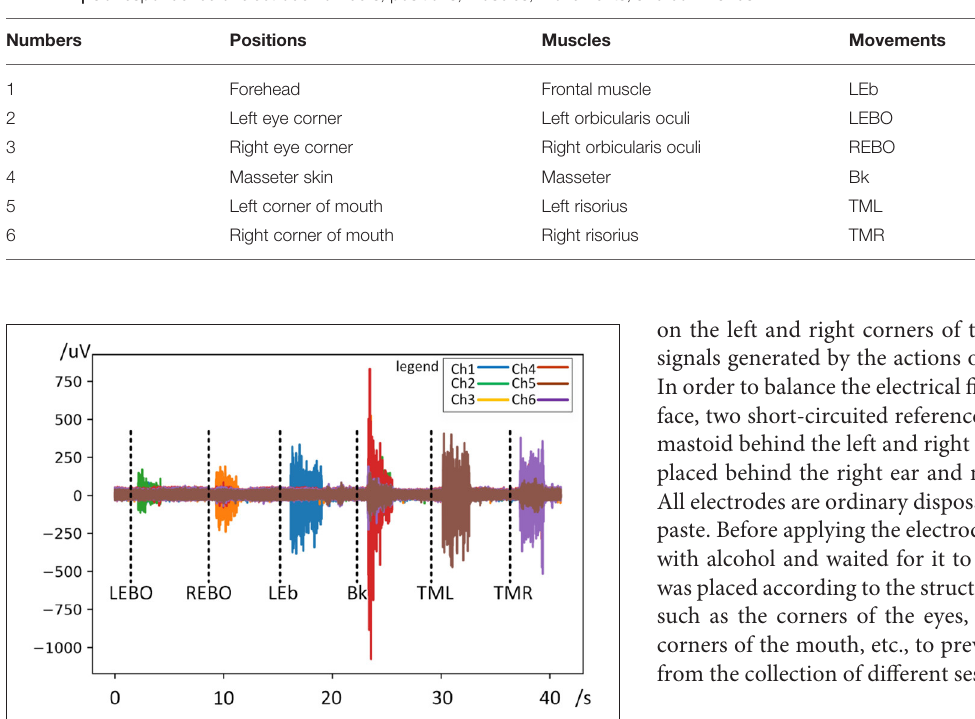
TABLE 1 | Correspondence of electrode numbers, positions, muscles, movements, and commands.